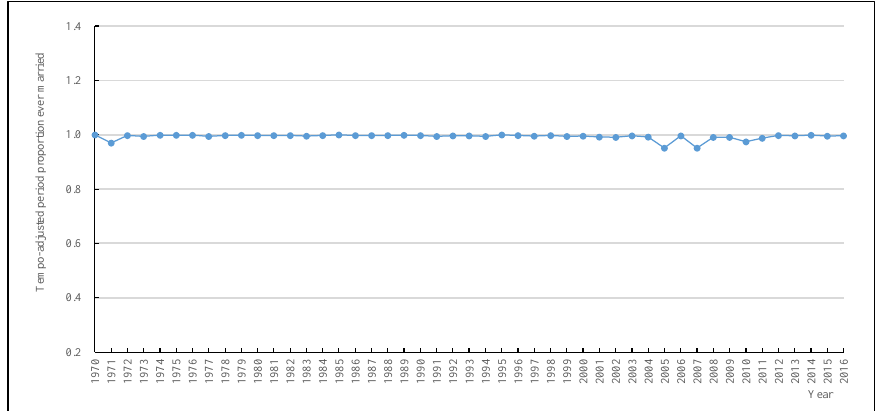
Figure 1. Total first marriage rate trends of Chinese women from 1970 to 2016. Source: 2005 China 1% Population Sample Survey and the 2017 China Fertility Sample Survey.